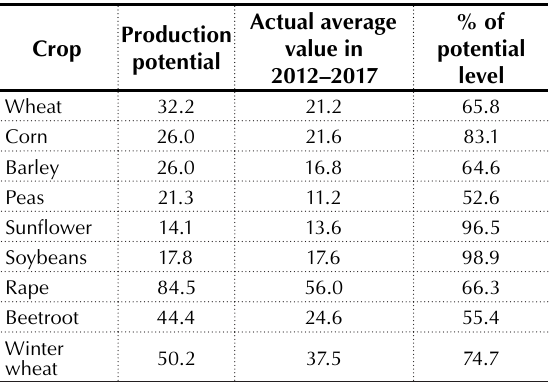
Table 7. Potential yields of main crops in all categories of farms in Cherkasy region